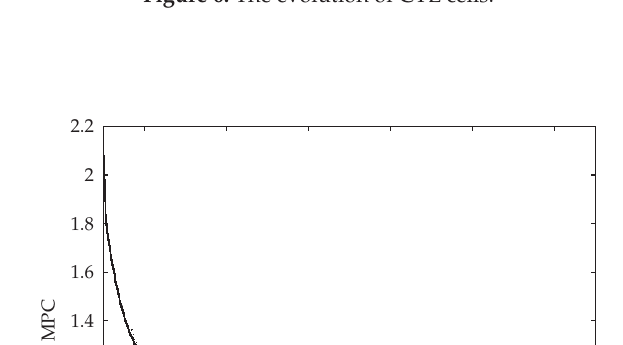
Figure 6: The evolution of CTL cells.